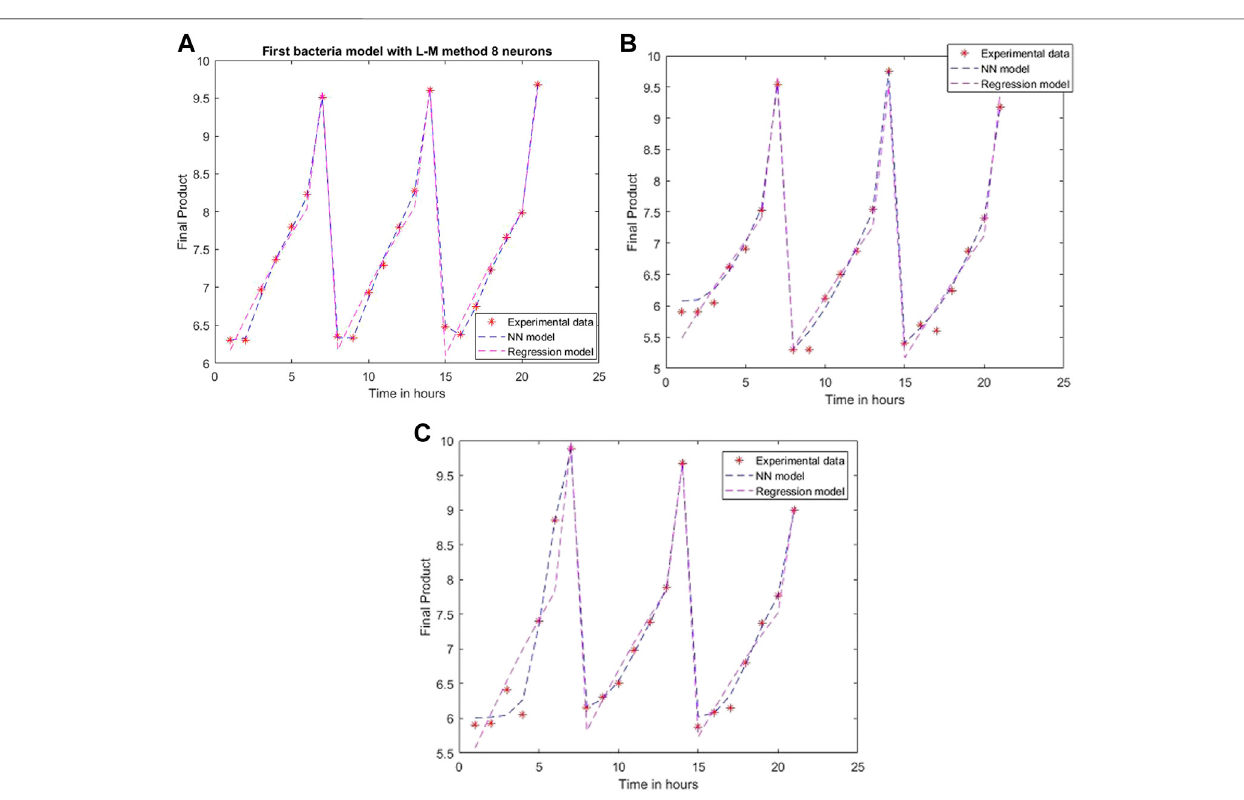
Frontiers in Bioengineering and Biotechnology |